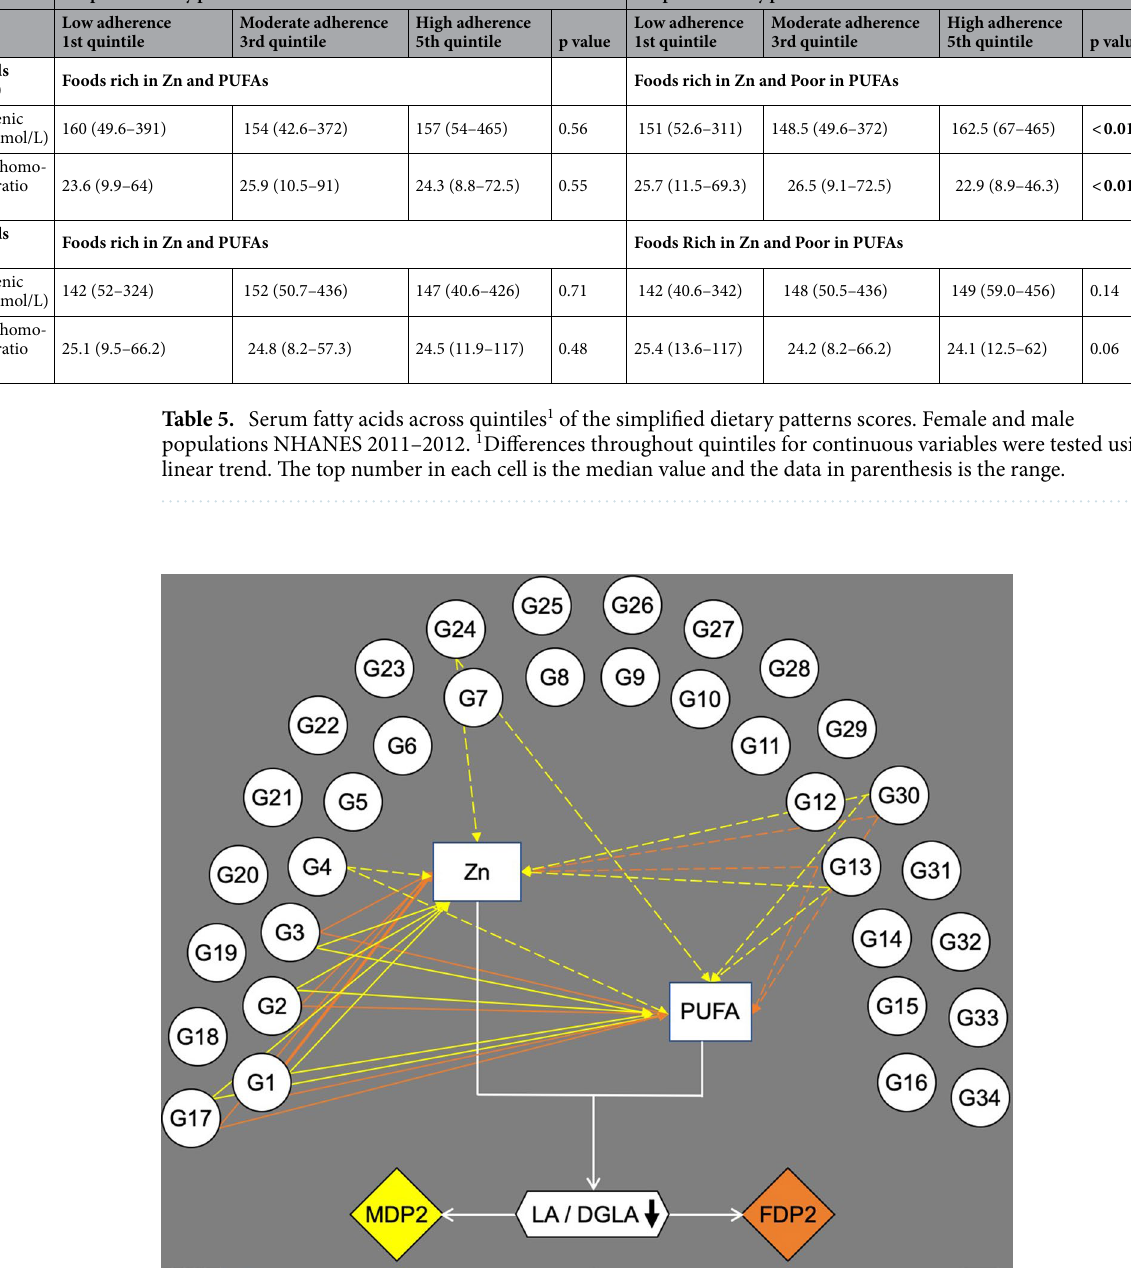
Figure 3. Pipeline and graphical results by which reduced rank regression identified food groups based on intake of zinc (Zn) and polyunsaturated fatty acids (PUFA) followed by multiple linear regression analysis to test for associations of dietary patterns and serum linoleic/dihomo-γ-linolenic ratio (LA/DGLA). Circles with G are the food groups, rectangles are Zn and PUFA intake values, diamonds are dietary patterns 2 for males (MDP2) and females (FDP2). Each dietary pattern (rectangles) is represented by a combination of food groups that explained as much variation of Zn and PUFAs intake. Solid lines are positive and dashed lines are negative associations between food groups and Zn and PUFAs intake. FDP2 and MDP2 (rich in Zn and poor in PUFAs) were associated with low LA/DGLA